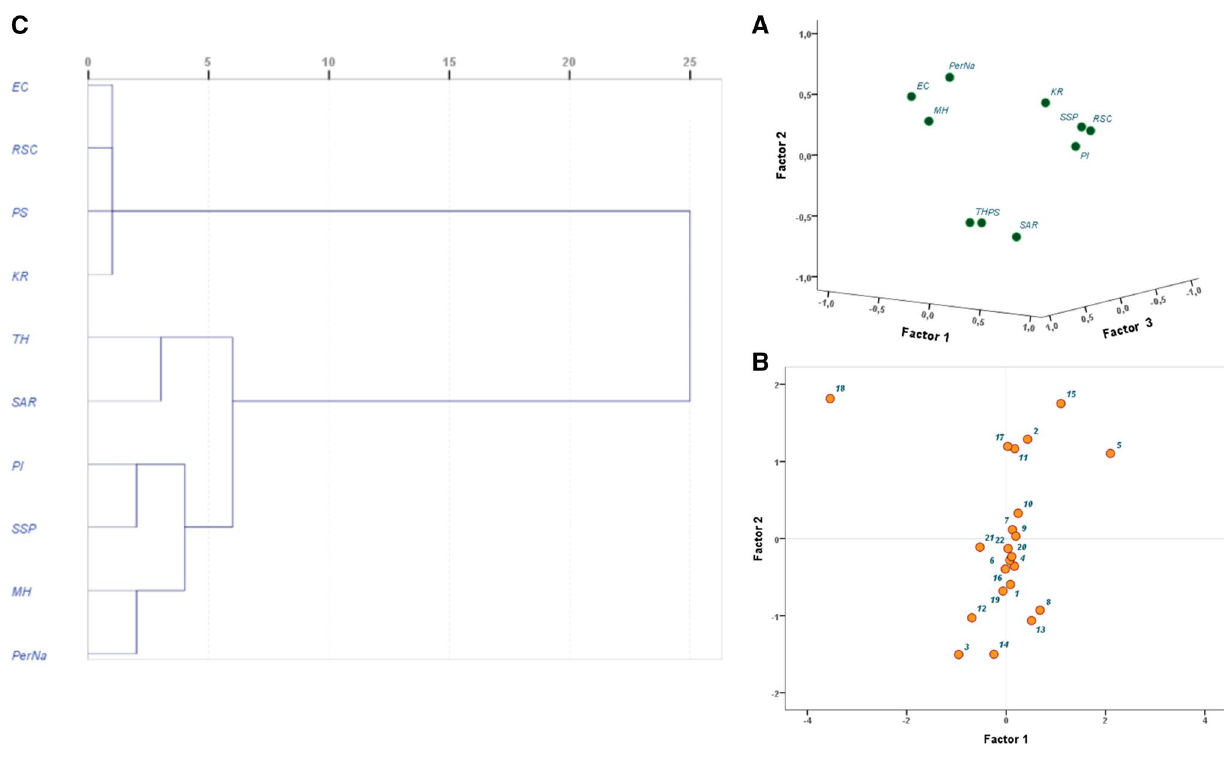
Fig. 9 Statistical results